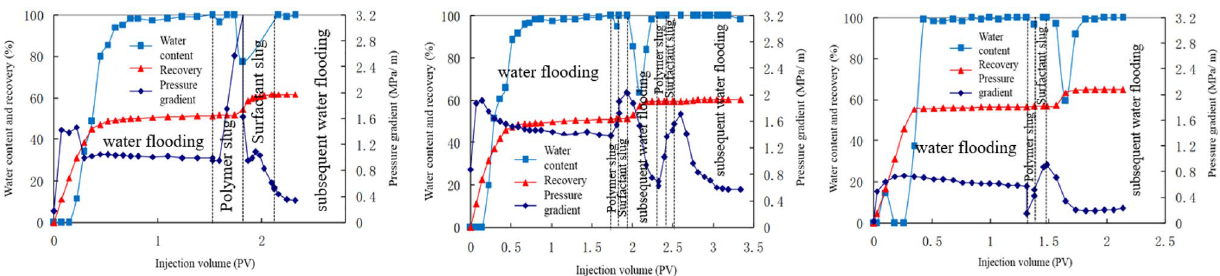
Fig. 18 Core flooding experiments results of Option A, B and C (from left to right)